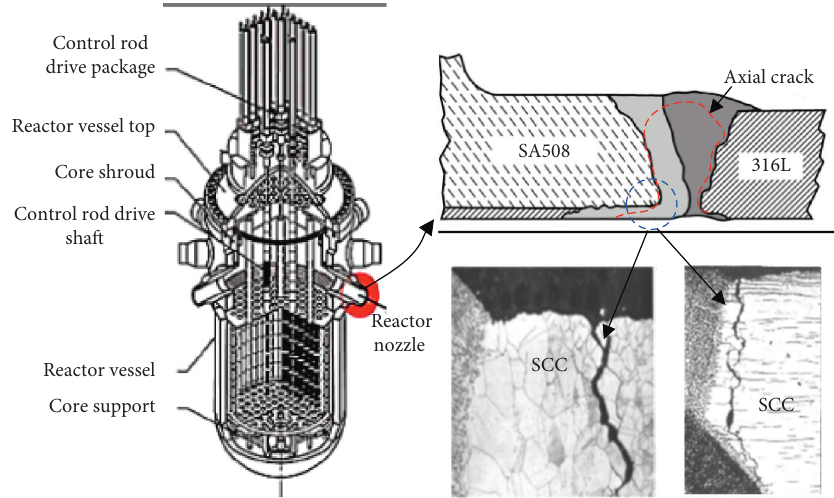
Figure 1: Schematic diagram of the stress corrosion cracking in the welded joint at the safe-end of the primary circuit of the